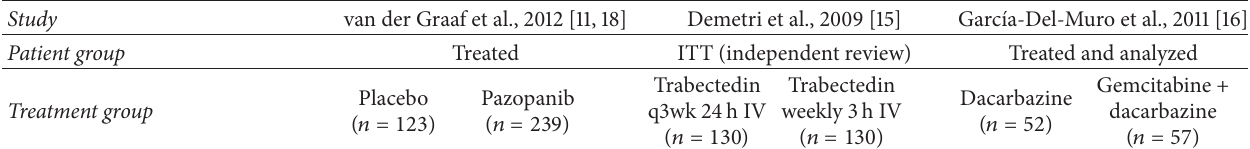
Table 3: Patients experiencing selected gastrointestinal and/or eating-related